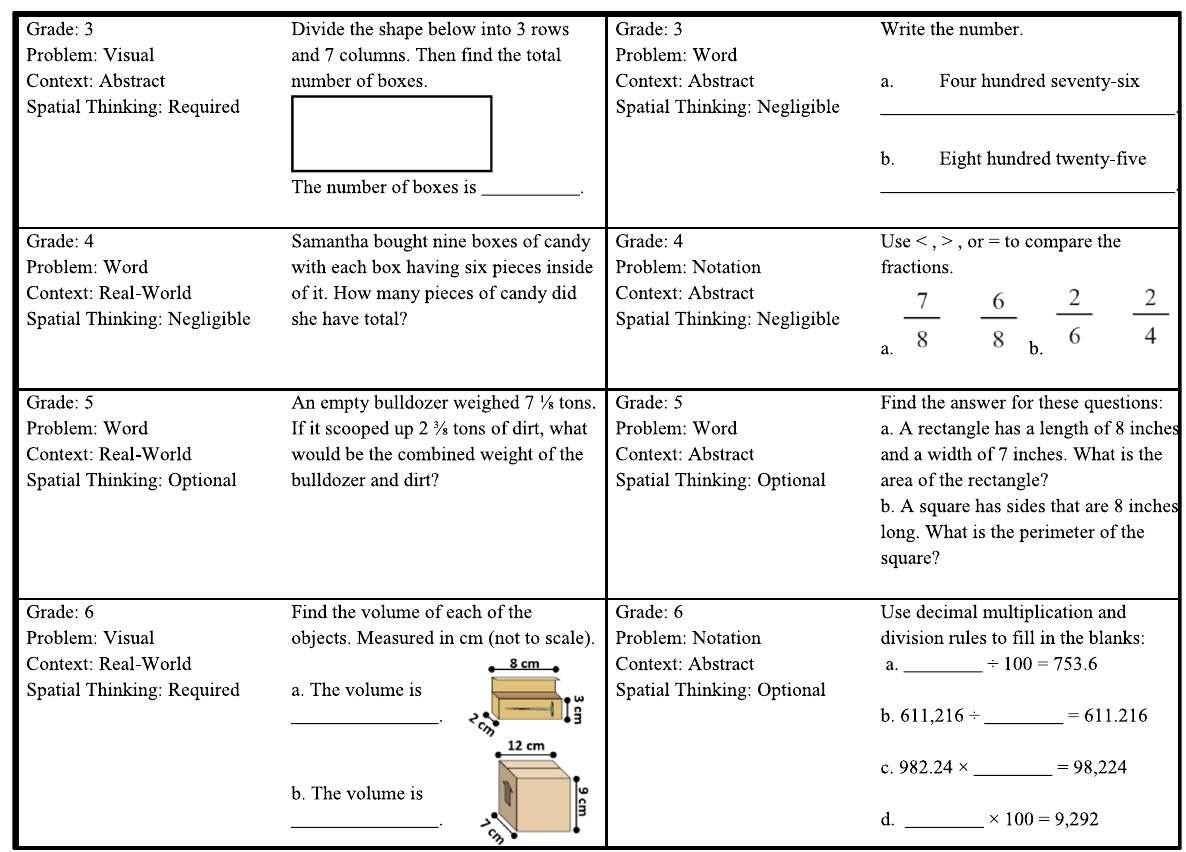
Fig. 2 Example Common Core Math problems categorized by problem type, context, and spatial thinking. Sourced from sourced from